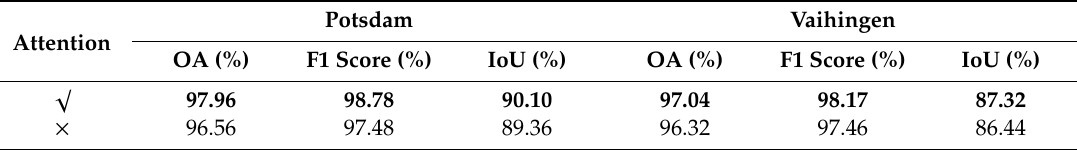
Table 4. Quantitative results of fusion networks with / without an attention